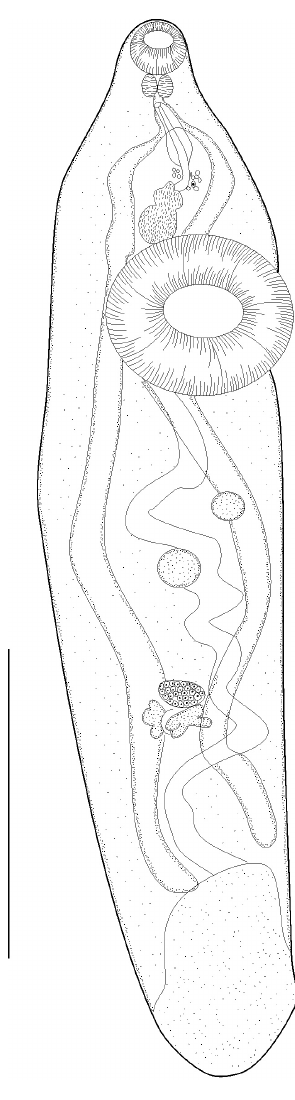
Fig. 1. – Lecithochirium sp. from Sardinella aurita . General morphology, ventral view. Scale bar = 150 μ